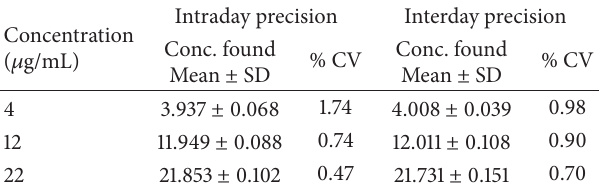
Table 3: Precision study of the proposed